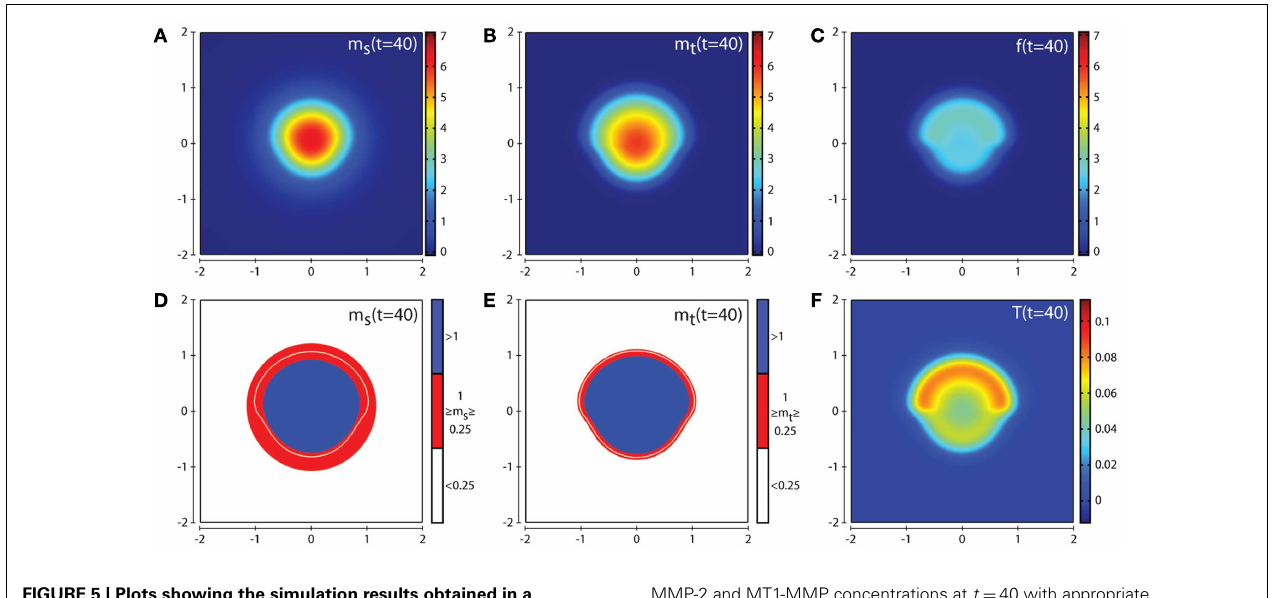
FIGURE 5 | Plots showing the simulation results obtained in a two-dimensional domain where asymmetric invasion of the ECM is achieved by the cancer cells. The concentrations of MMP-2, MT1-MMP, the intermediary complex f , andTIMP2 at t = 40 (corresponding to ∼ 4.6days) are shown in plots (A–C,F) respectively. Plots (D,E) show the